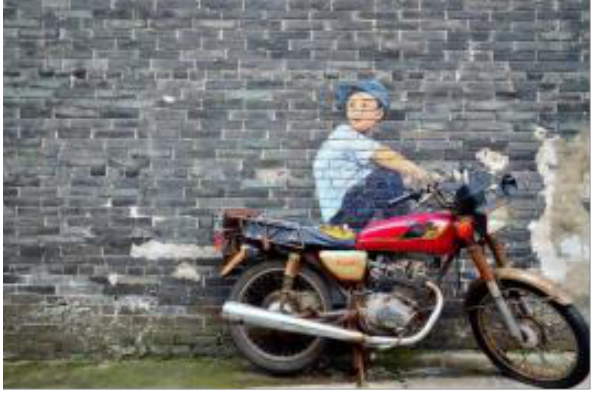
Figure 18. Graffiti in Shawan Town (Source: The authors).